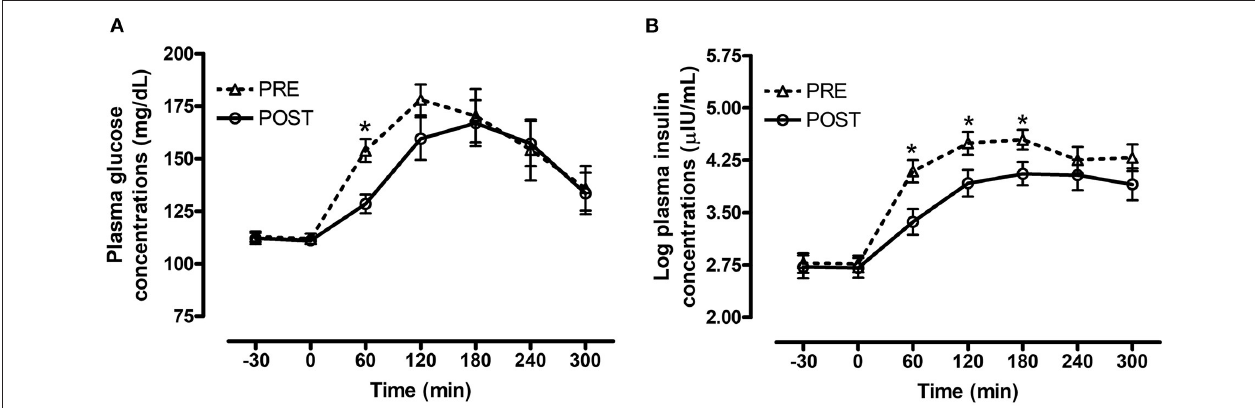
FIGURE 2 | Effect of bromocriptine on postprandial glucose and insulin responses to feeding a meal of whole oats. Postprandial plasma glucose and log insulin concentrations following consumption of a meal of whole oats providing 1g starch/kg BW before and after 14 days of bromocriptine treatment. (A) Effect of bromocriptine (bromo* time interaction P = 0.008) on glucose concentrations (mg/dL) at baseline (-30, 0min) and 60, 120, 180, 240, and 300min post feeding. (B) Effect of bromocriptine (bromo* time interaction P = 0.001) on log insulin concentrations ( µ IU/mL) at baseline ( − 30, 0min) and 60, 120, 180, 240, and 300min post feeding. Dotted line with triangles: measurements before start of bromocriptine treatment ( n = 13); Solid line with circles: measurements after 14 days of bromocriptine treatment ( n = 10). Data of horses that did not consume their meal within 60min were removed from the final analysis. Data are presented as least square means ± standard error of the mean. *Indicates differences ( P ≤ 0.05) between pre and post bromo plasma metabolite concentrations at specific timepoints. ID, insulin dysregulated horses; INS, effect of insulin status.